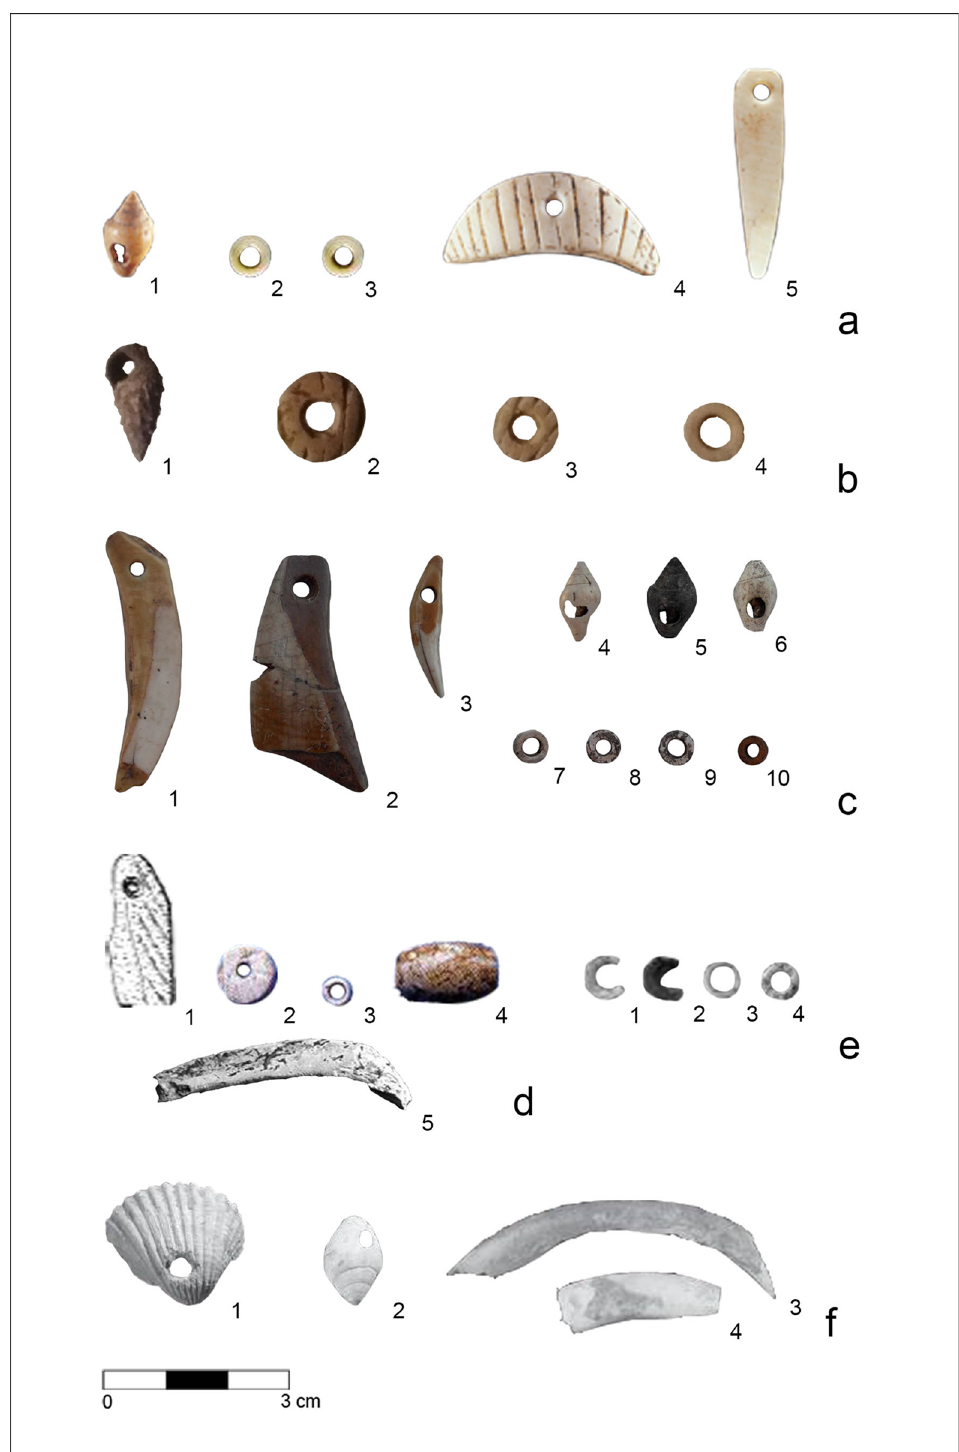
Figure 6: Selection of Italian early Neolithic hard animal matter ornaments. ( a ) Arene Candide Cave ( Borrello, 2005; Micheli, Panelli, Rossi, & Maggi, 2018 ) ; ( b ) Cala Giovanna Piano - Pianosa Island ( Bisconti & Zamagni, 2007 ) ; ( c ) Colle Santo Stefano ( Graniti, 2008 ) ; ( d ) Torre Sabea ( Micheli, 2003; Radi, 2003 ) ; ( e ) Mora Cavorso Cave ( Silvestri et al., 2020 ) ; and ( f ) Ripatetta ( Zamagni, 2006 ) . Elaboration by A.